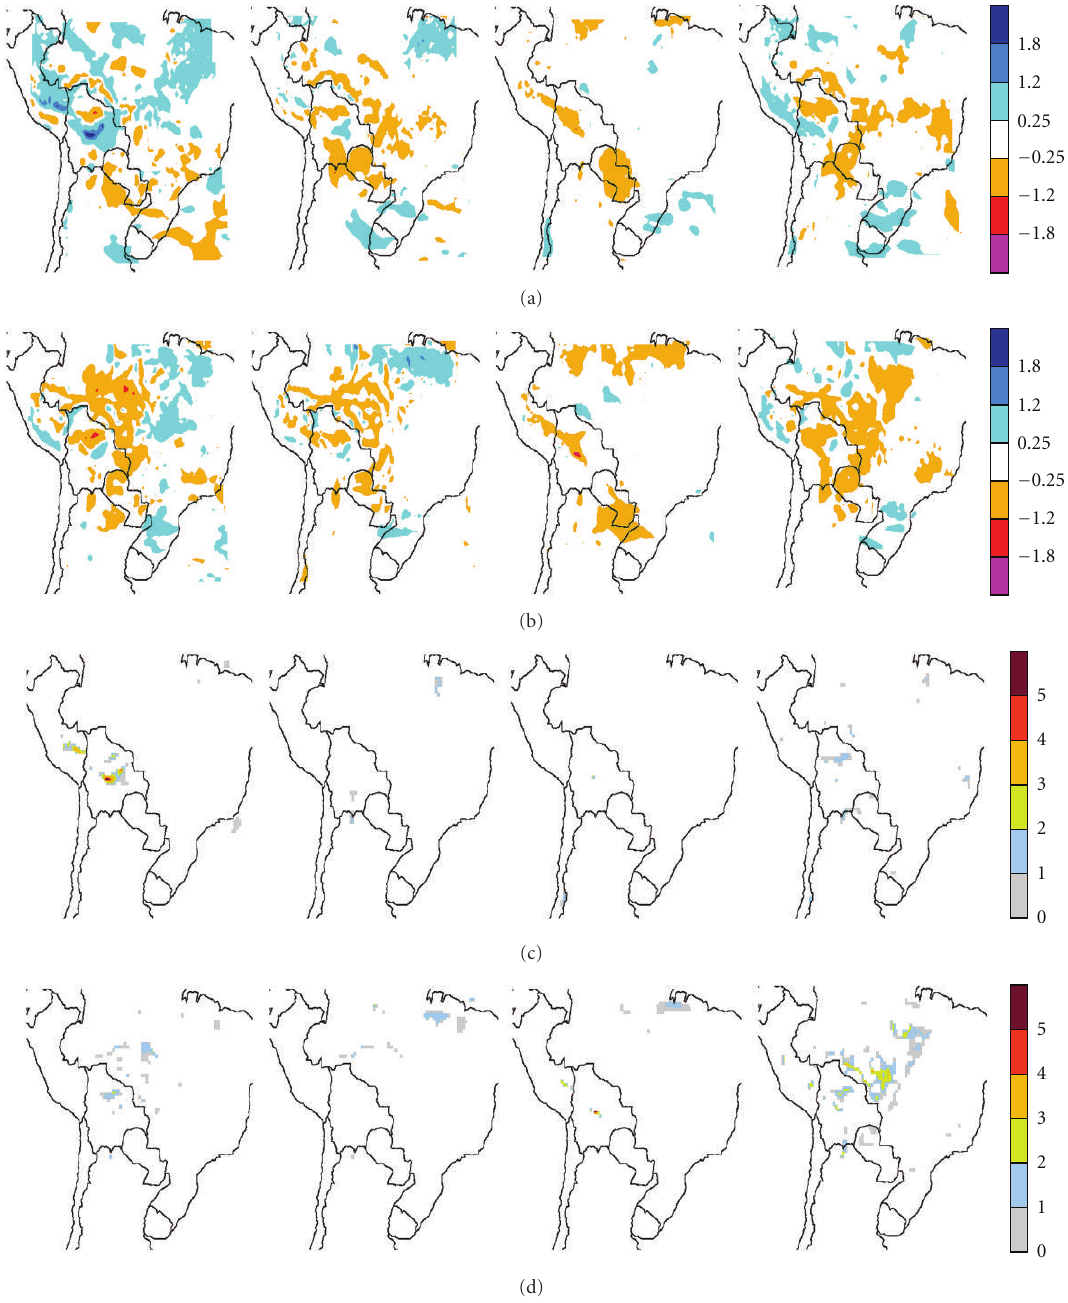
Figure 9: Same as Figure 8 for ERA-40-driven PRECIS